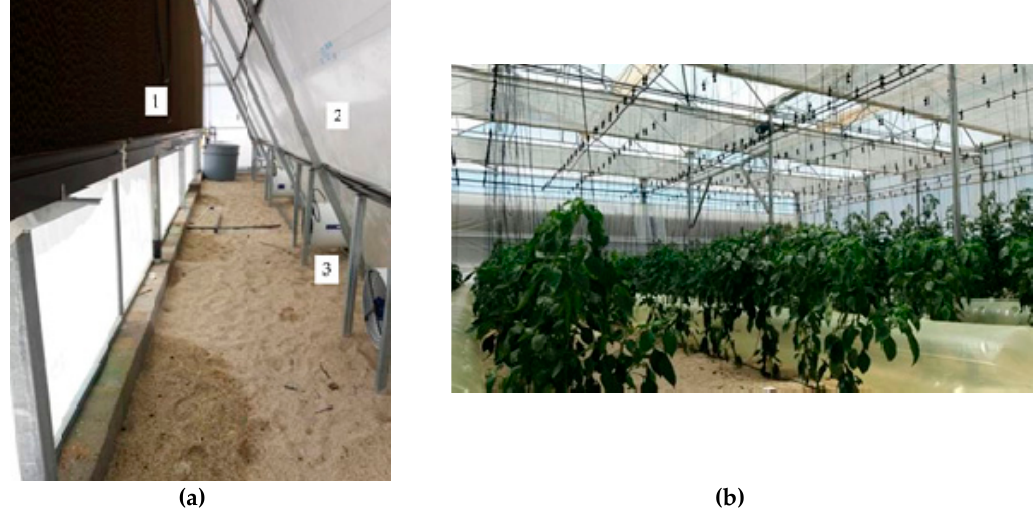
Figure 2. Greenhouse. ( a ) Fan-pad system, pre-chamber and extractors. ( b ) Distribution air ducts.